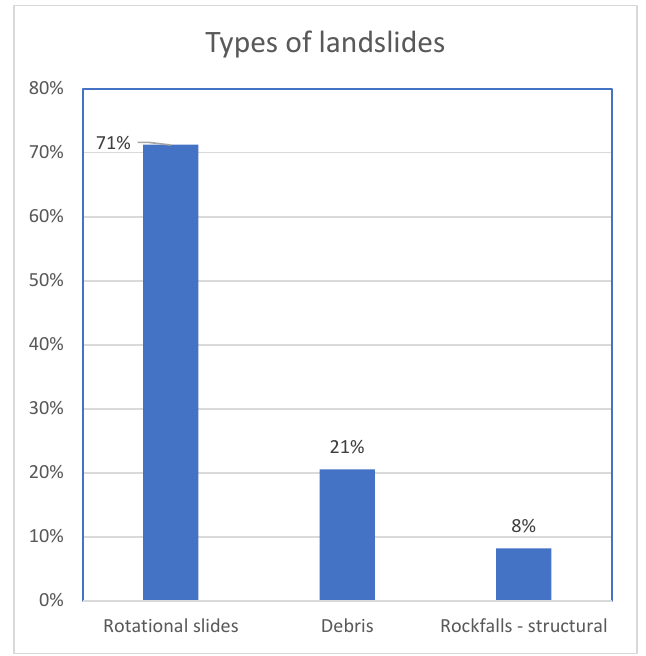
Figure 5. Types of landslides identified in the field reconnaissance surveys.